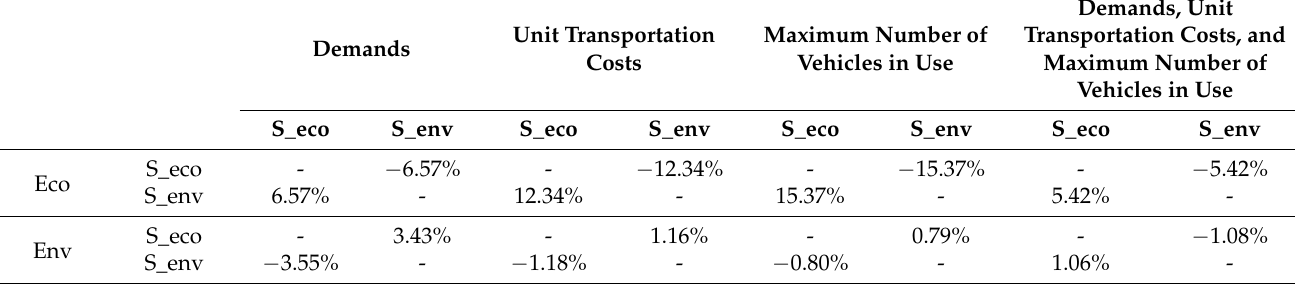
Table 11. Gaps obtained in the two